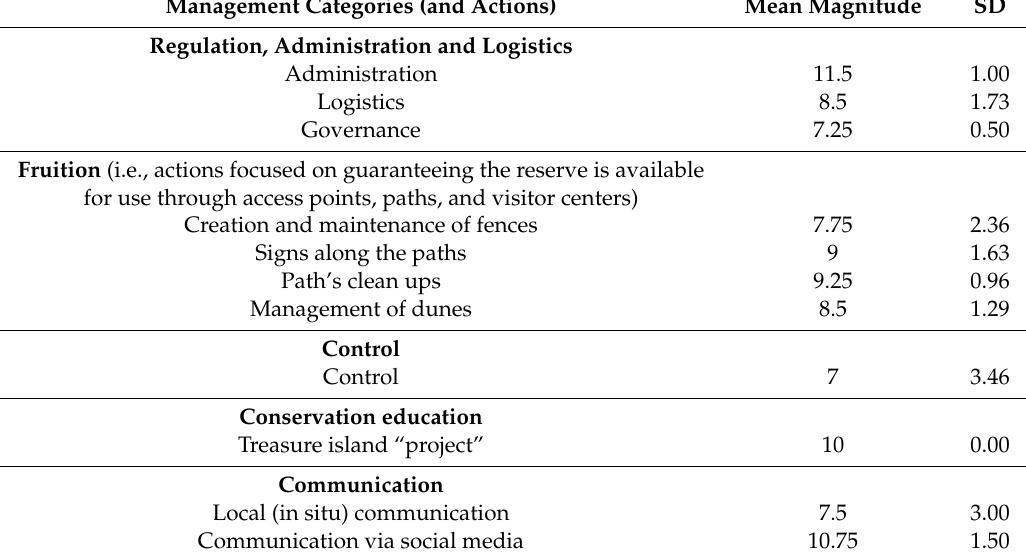
Figure 1. Mean magnitude scores (and standard deviations) for the management actions selected.